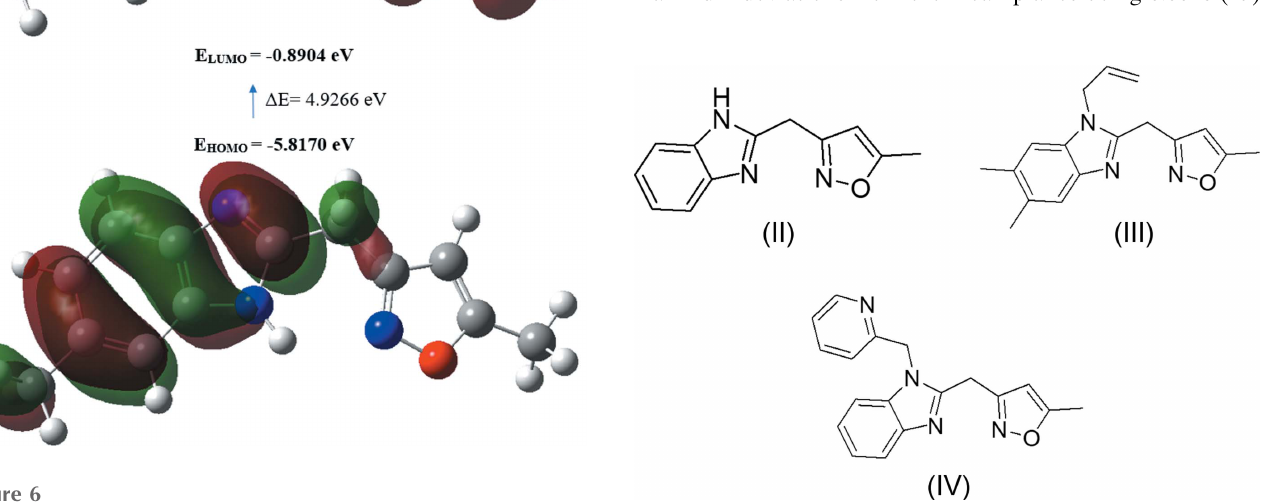
Figure 7 Structural fragments (II), (III) and (IV) used in the database survey.